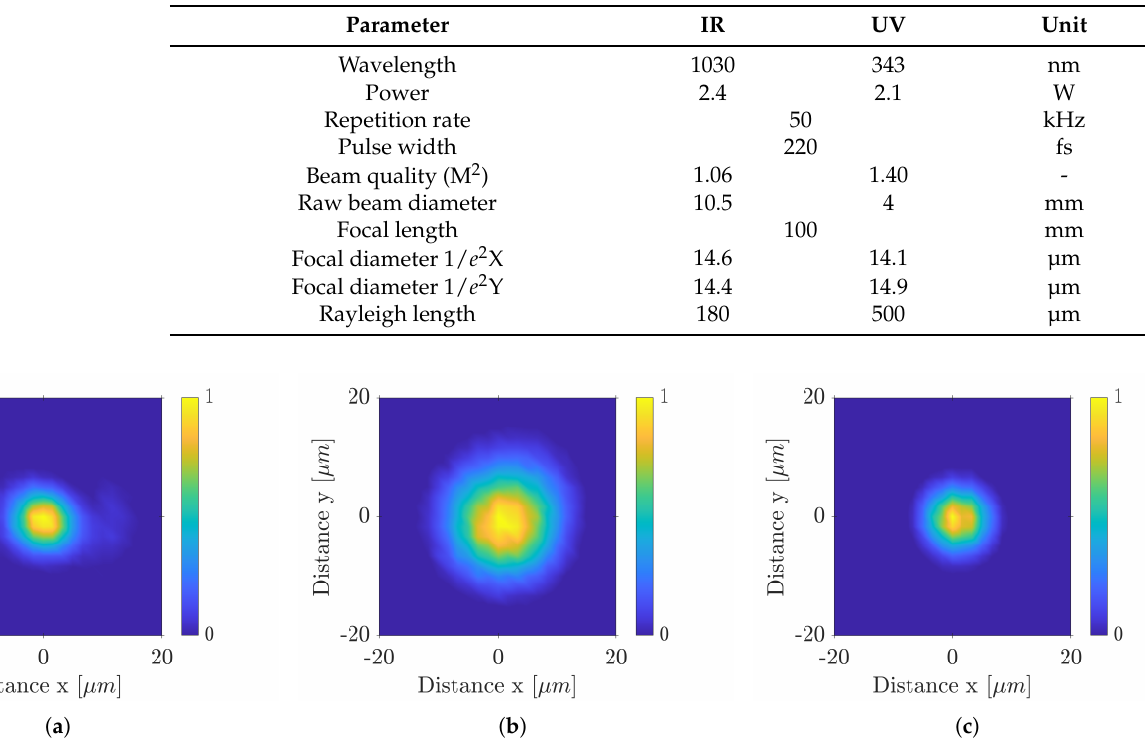
Figure 1. Schematic illustration of the laser-machining setup with the wavelengths 343nm and 1030nm. Table 1. Specification of the laser system in the fundamental wavelength with BET and 3rd harmonic wavelength at optimized repetition rate.